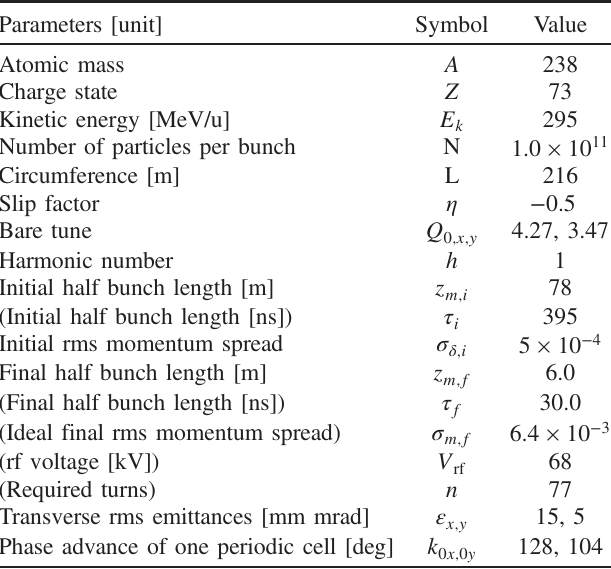
TABLE I. Main parameters for an example bunch compression in SIS-18.